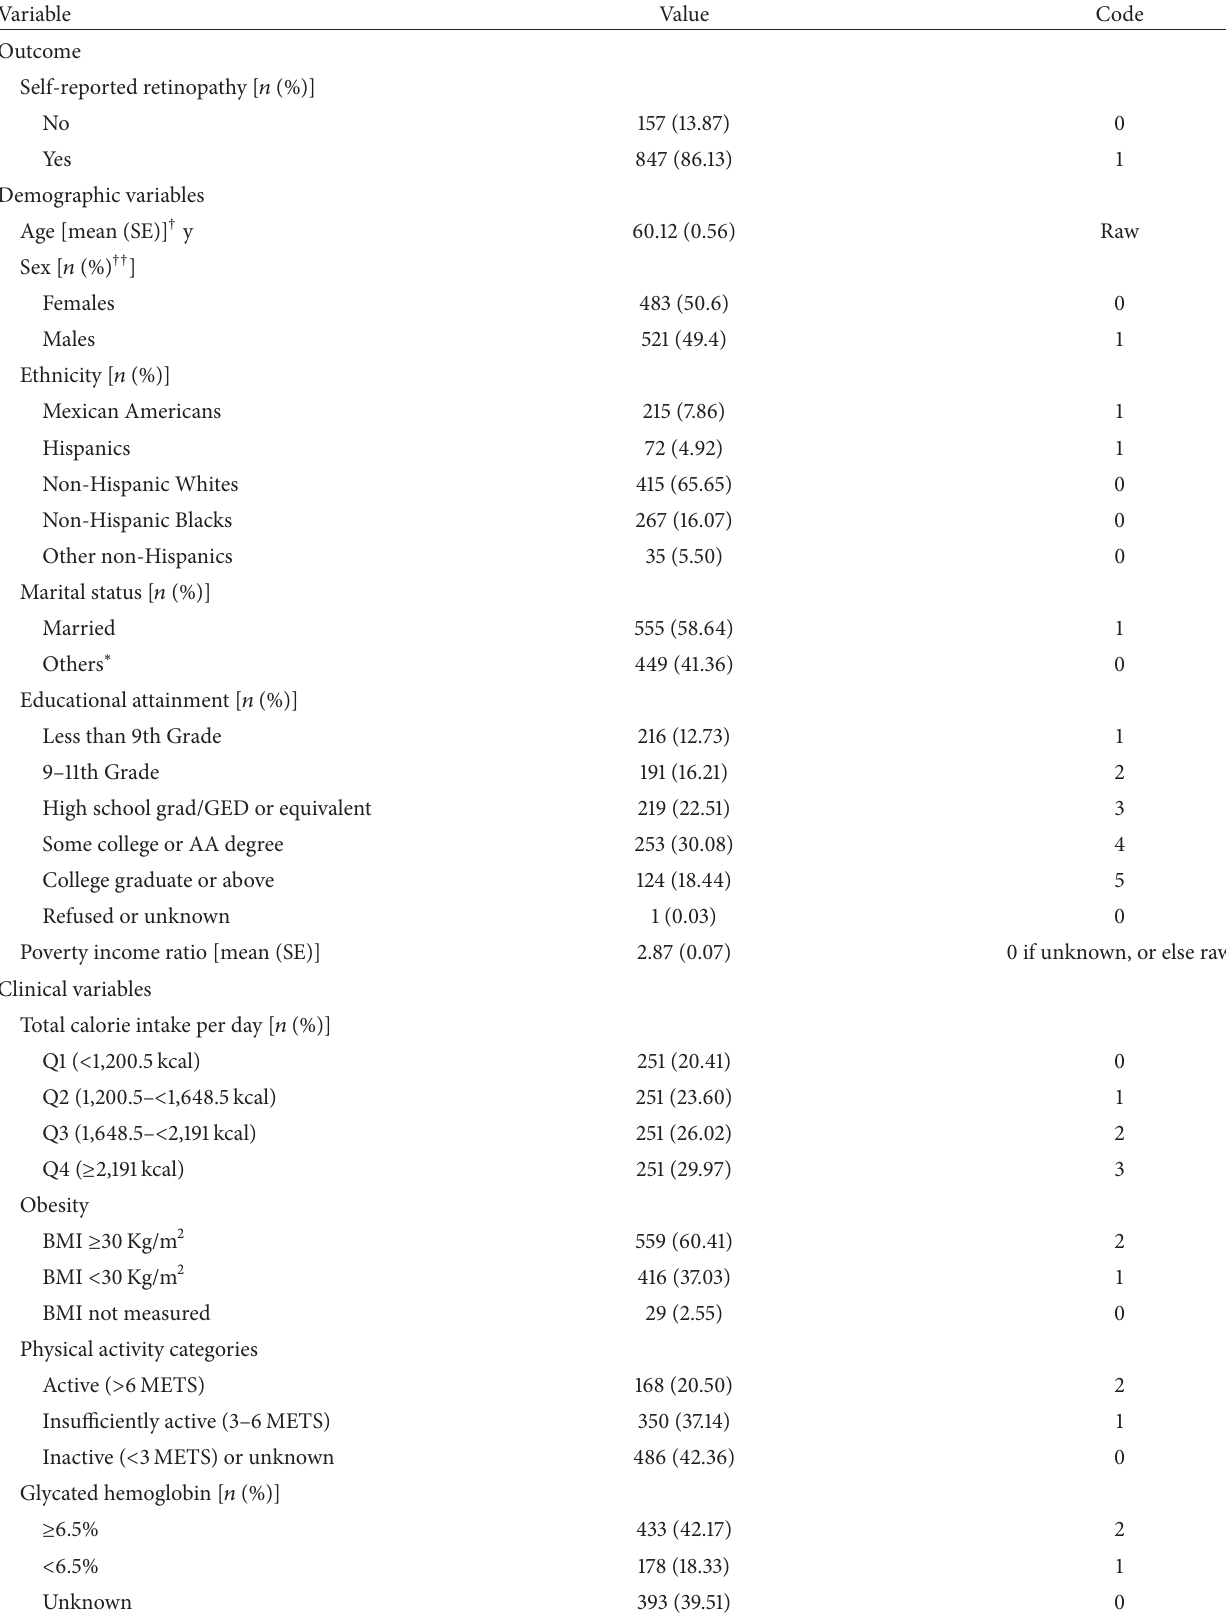
Table 1: Outcome and potential confounders considered in the